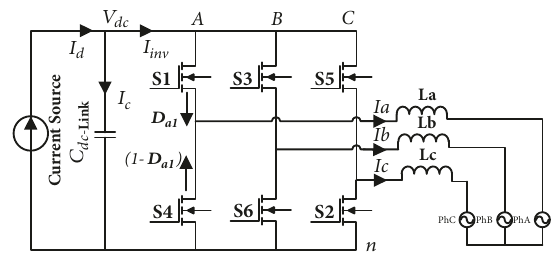
Figure 1: Three-phase inverter 120BCM with modulated DC